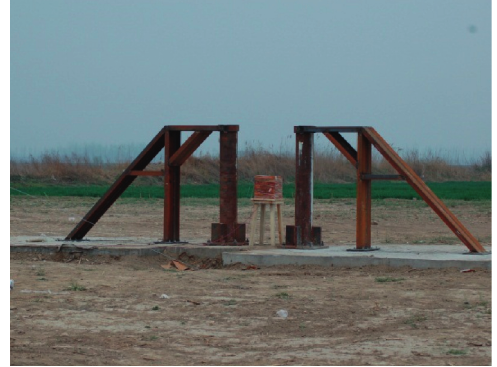
Figure 5: Photograph of test site.